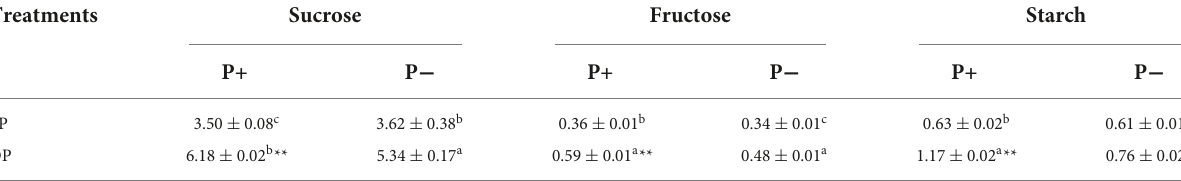
TABLE 2 Concentration of unstructured carbohydrates in the roots of both sides of dual-root soybeans (mg/g FW).